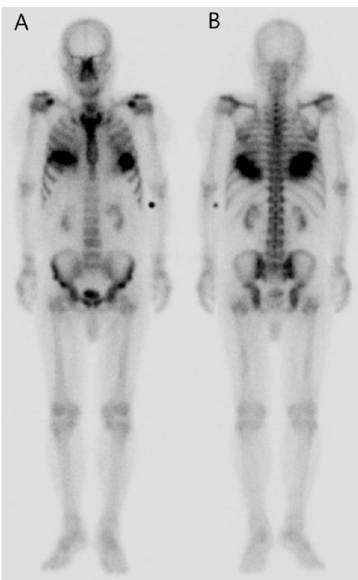
Figure 3. Both anterior ( A ) and posterior ( B ) images of the bone scan revealed significantly increased diffuse MDP uptake in the bilateral lower lung fields.